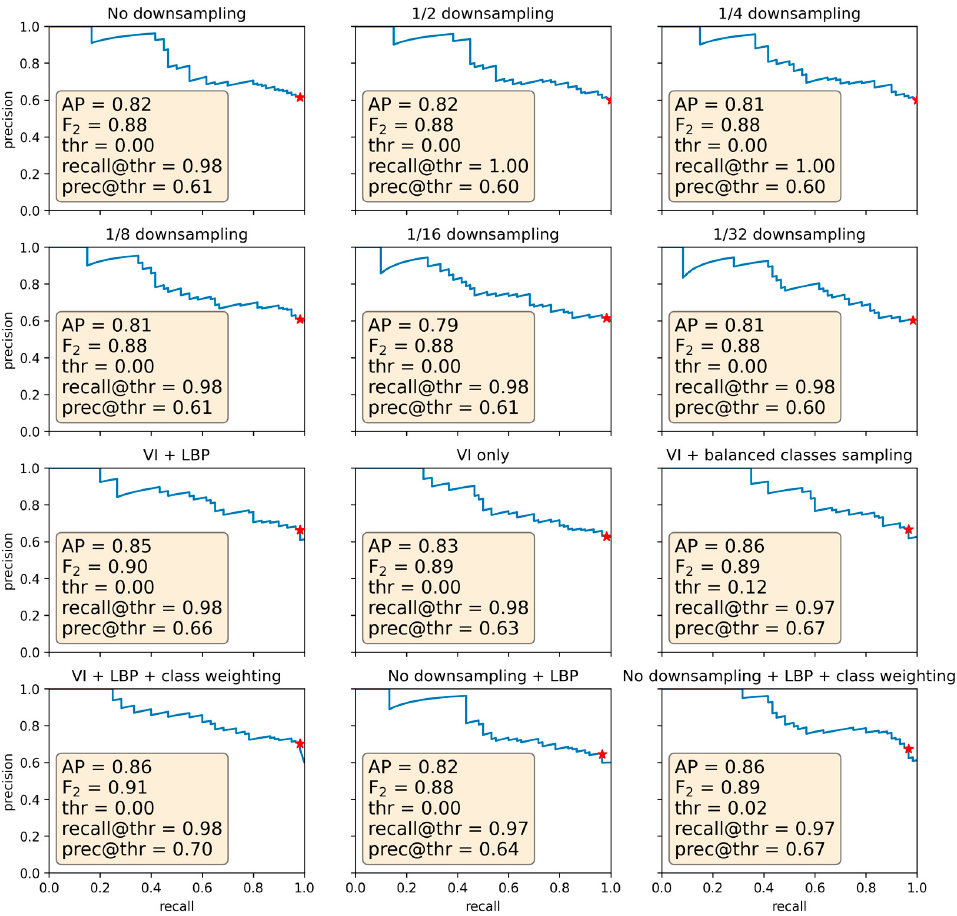
Figure 7. Precision‑recall curves for different classifiers (indicated above the figures). Inset shows values for Average Precision (AP), F 2 score, optimal damage fraction threshold, recall, and precision values at that threshold (corresponding point on the curve marked as red ☆ ).